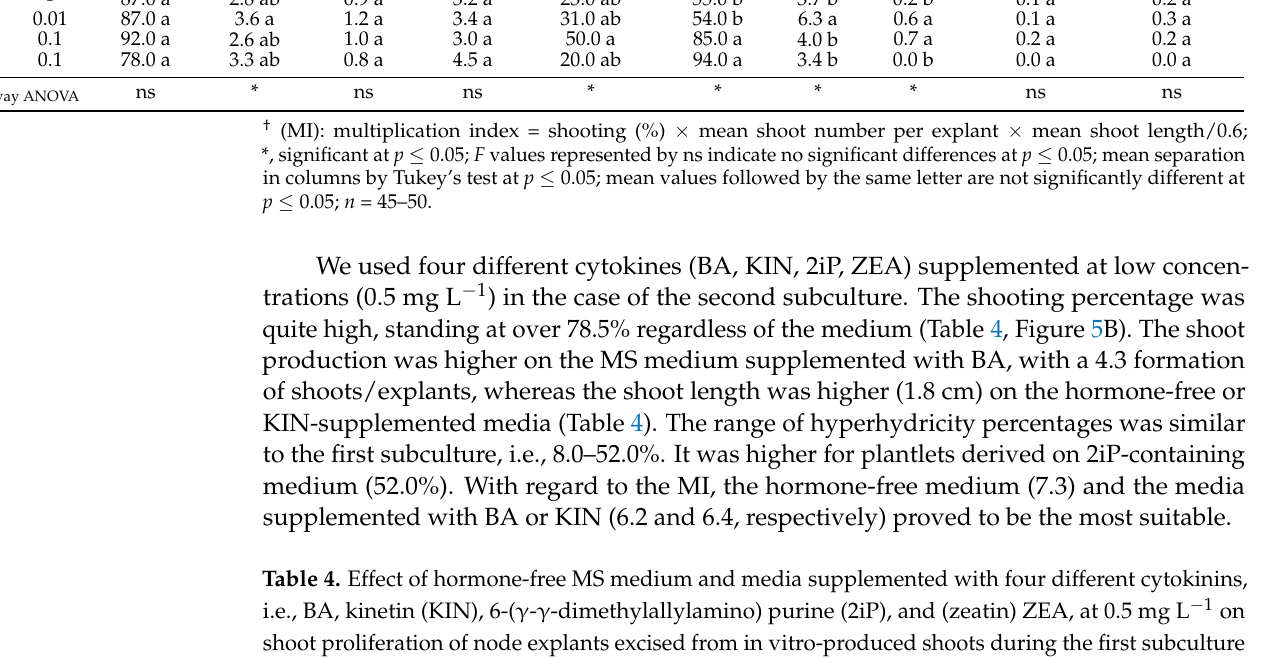
Table 4. Effect of hormone-free MS medium and media supplemented with four different cytokinins, i.e., BA, kinetin (KIN), 6-( γ - γ -dimethylallylamino) purine (2iP), and (zeatin) ZEA, at 0.5 mg L − 1